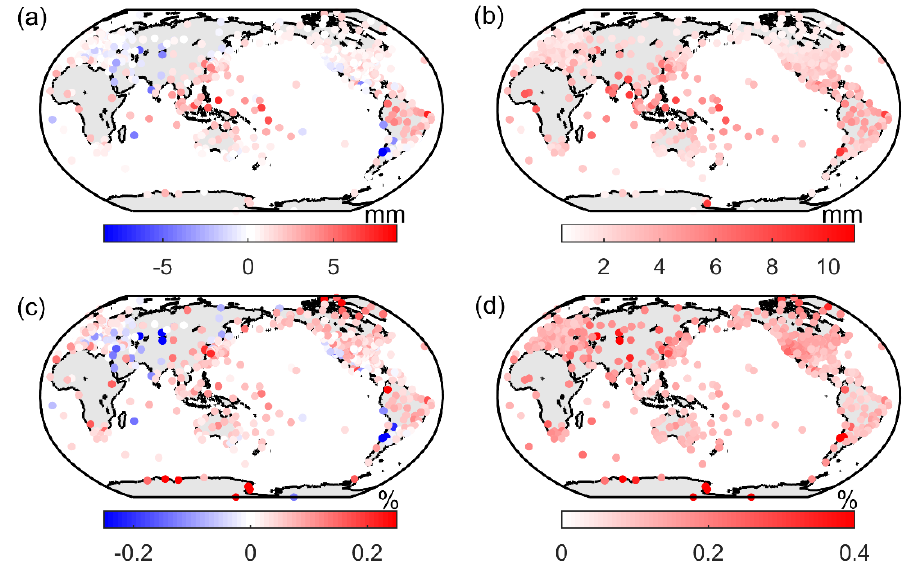
Figure 3. Bias ( a ), relative bias ( c ) (in % relative to mean PWV), root mean square error (RMSE) ( b ), and normalized RMSE ( d ) of 1534 pairs of NGL global navigation satellite system (GNSS) and Integrated Global Radiosonde Archive Version 2 (IGRA2) RS stations.